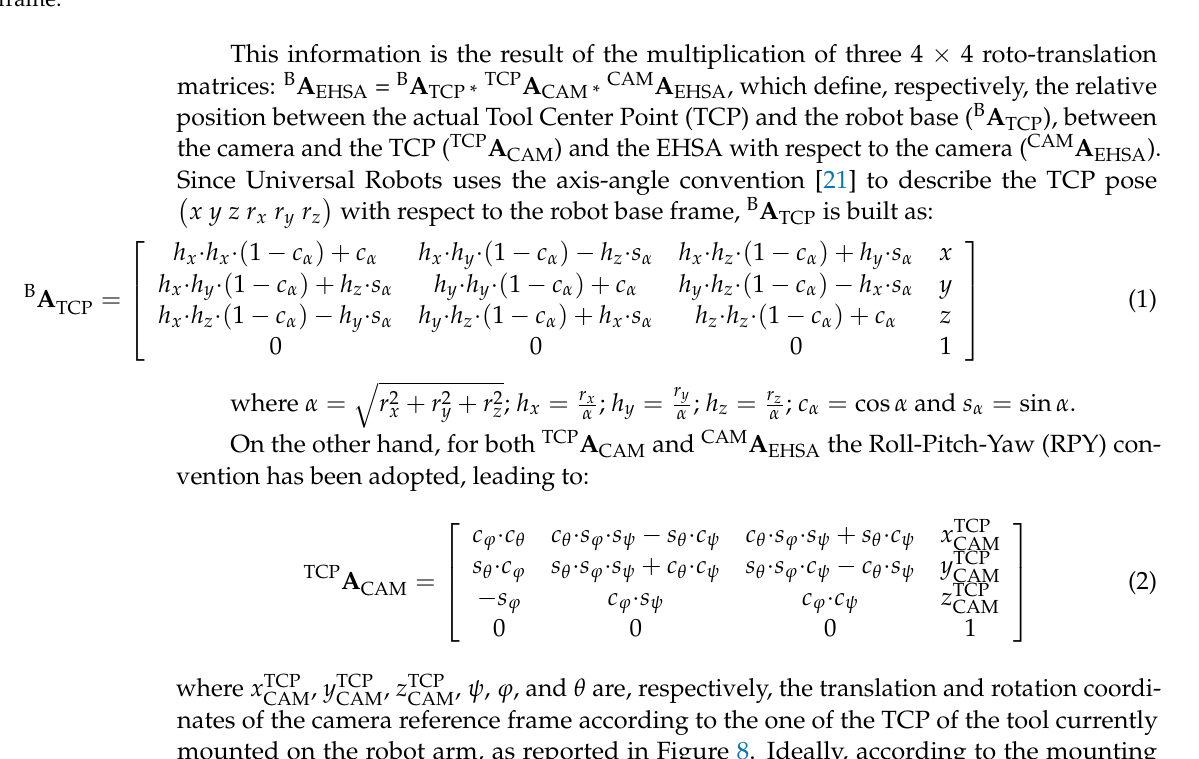
Figure 7. ( a ) Setting of the EHSA reference frame with the camera using the checkerboard on the fixture on which the servo-actuator is mounted; ( b ) View of the checkerboard from the camera while updating the coordinates of the EHSA reference frame.